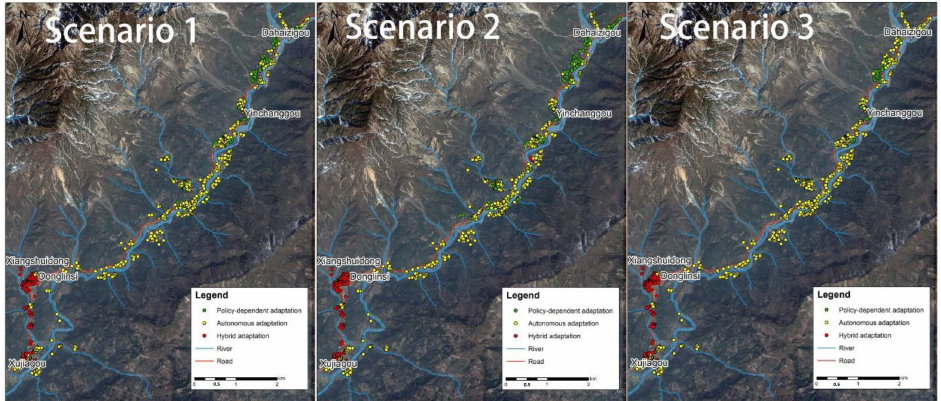
Figure 7. Results of the predicted changes in landslide adaptation strategies according to the three